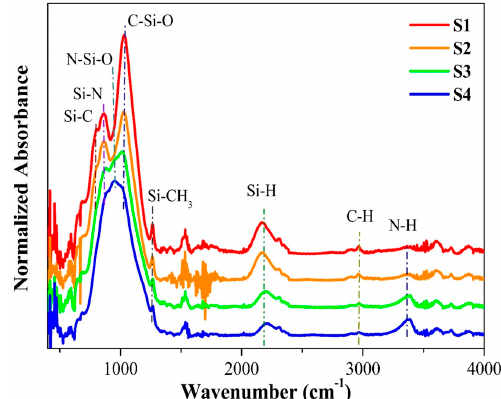
Figure 4. Fourier transform infrared (FTIR) spectra of the SiCO:N films grown at different NH 3 flow rates.